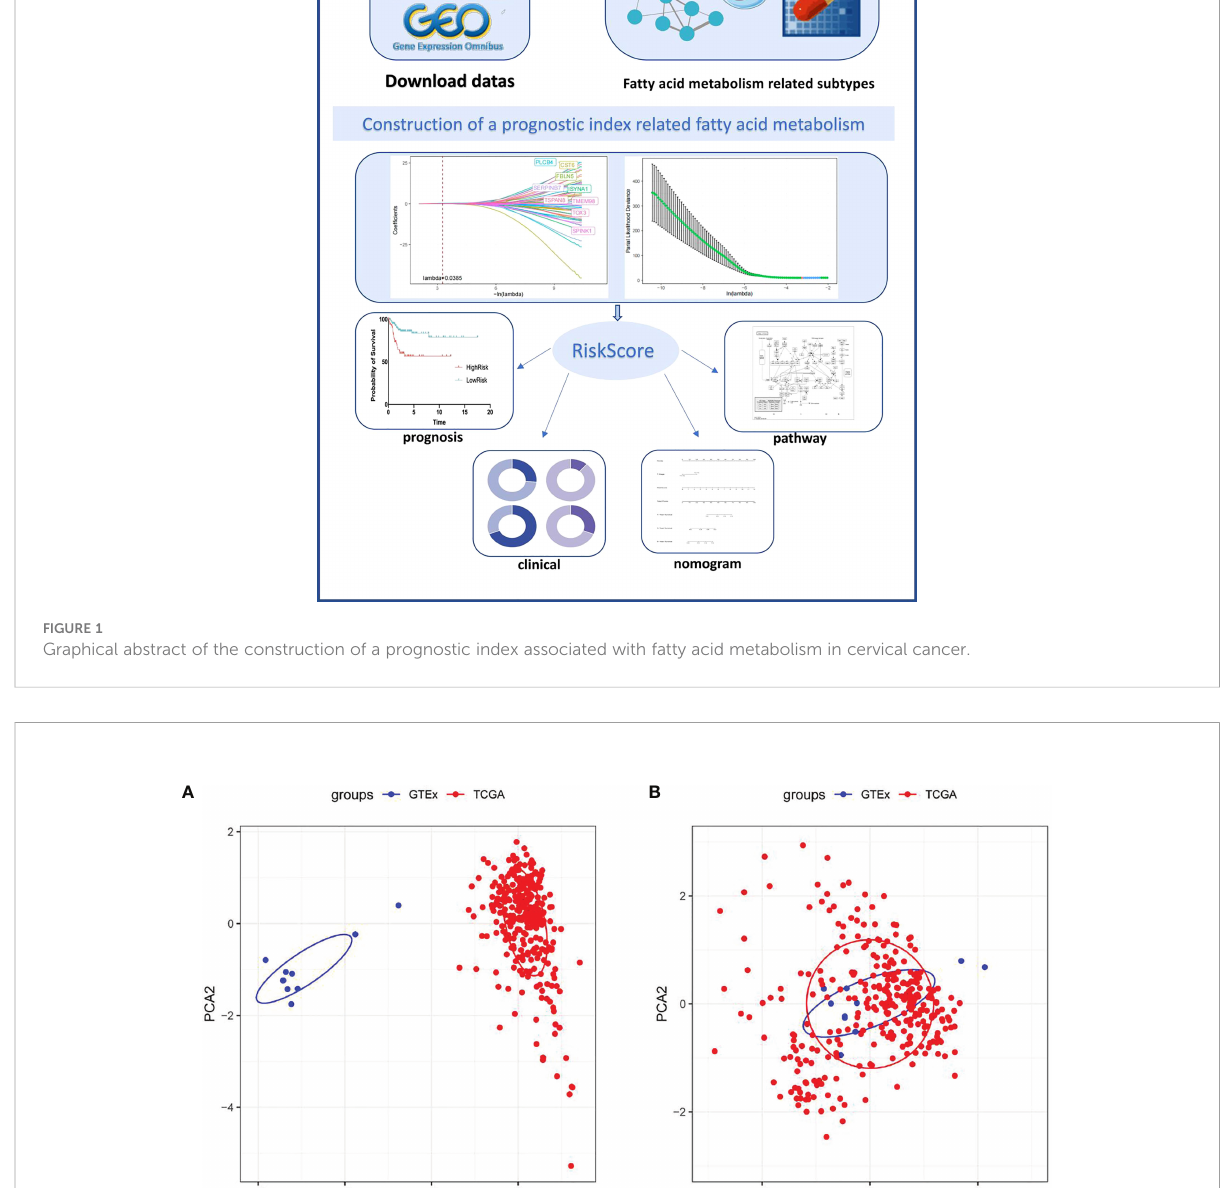
FIGURE 2 Evaluation of sample clustering by the principal component analysis (PCA) (A) PCA diagram between two data sets before the batch effect was removed; (B) PCA diagram between two data sets after the batch effect was removed. TCGA, The Cancer Genome Atlas; GTEx, Genotype- Tissue